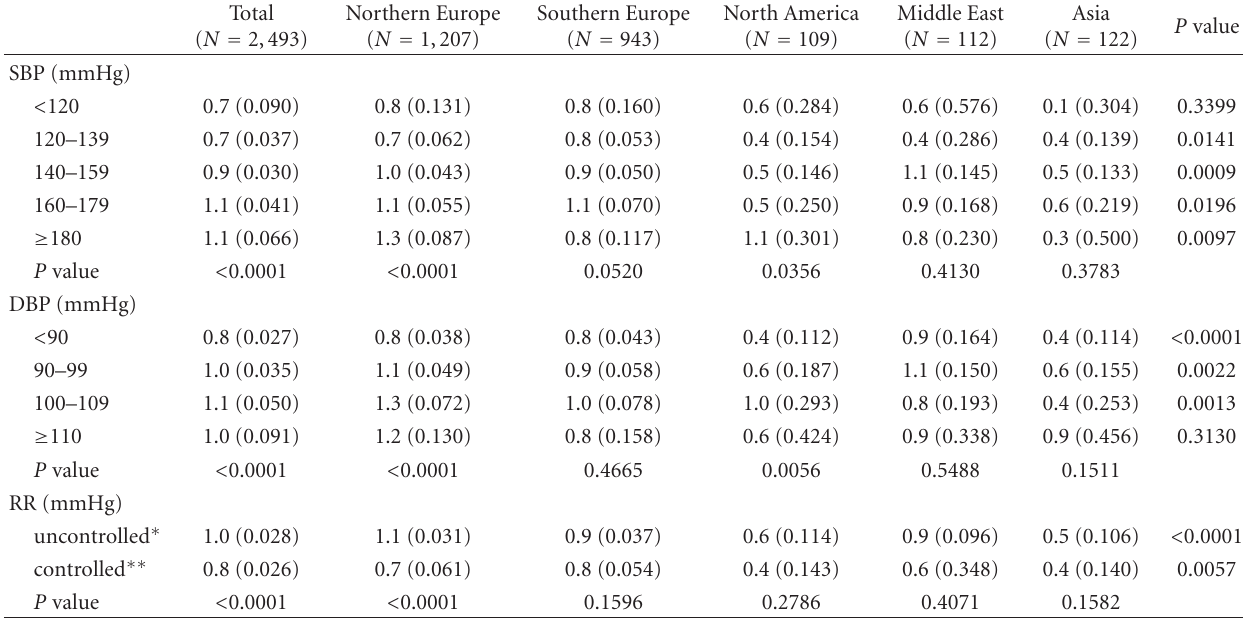
Table 9: Blood pressure and CRP (mg/dL ± SD, adjusted for age, and